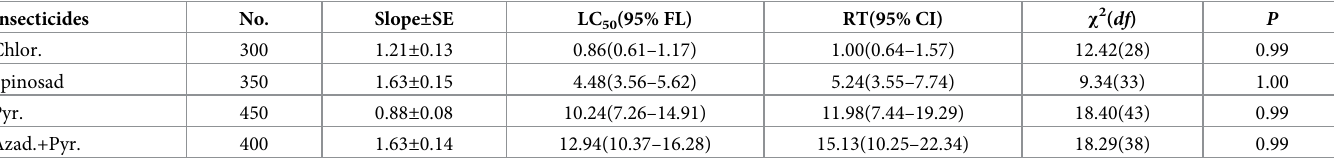
Table 3. Relative toxicity (RT) of insecticides to the 3 rd instar beet armyworm, Spodoptera exigua in oral toxicity bioassay at 95% confidence interval.